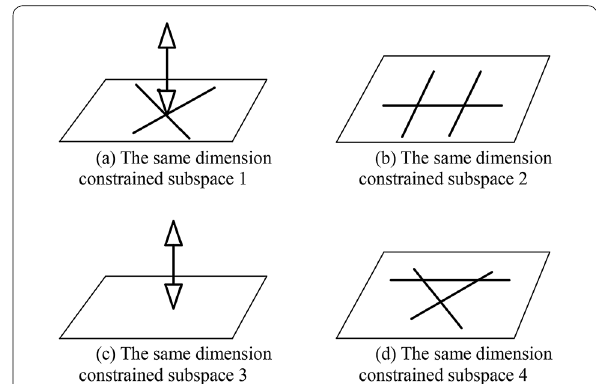
Figure 3 The same dimension constrained subspace